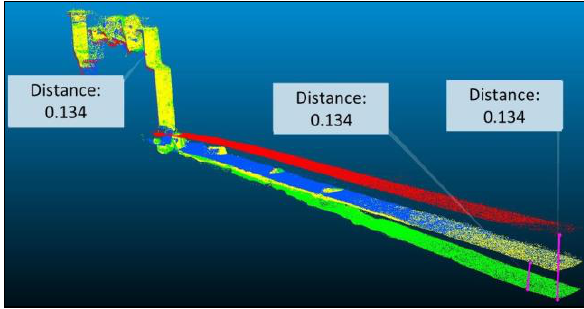
Figure 16 . Close view of the topographic variations [m]